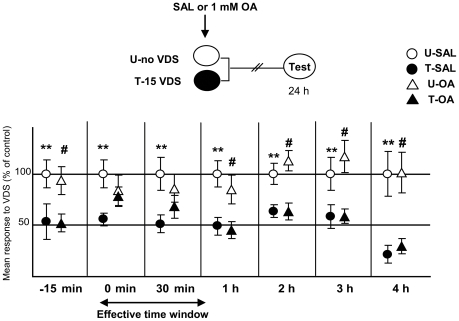
OA has a limited time window of effect over aversive memory.(Upper diagrams): Experimental protocol. Summary of seven experiments where SAL or 1 mM OA were injected −15 min (pre-training), 0 min, 30 min, 1 hour, 2 hours, 3 hours or 4 hours after training. Symbols as in Fig. 2. (Lower panels): Results of the Testing session. Circles stand for SAL injected pairs and triangles for OA injected pairs. The effective time window is demarcated by an arrow. **: p<0.01 for comparisons between SAL-injected U–T groups; #: p<0.01 for comparisons between OA- injected U–T groups. Ordinates as in Fig. 2. N per group displayed in Table 2.